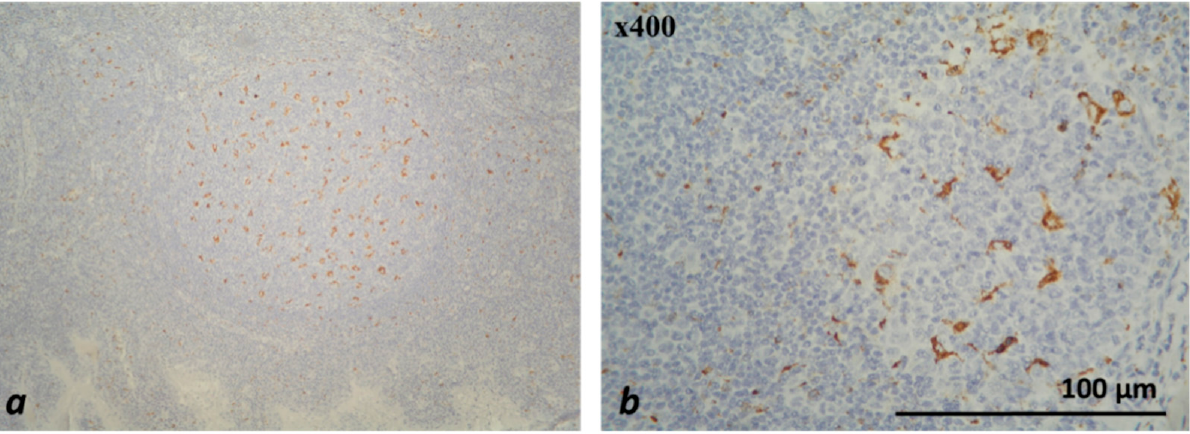
Figure 2. Microscopic evaluation of IHC-stained CD68+ macrophages (colored brownish) in tonsil— ×200 ( a ), ×400 ( b ).